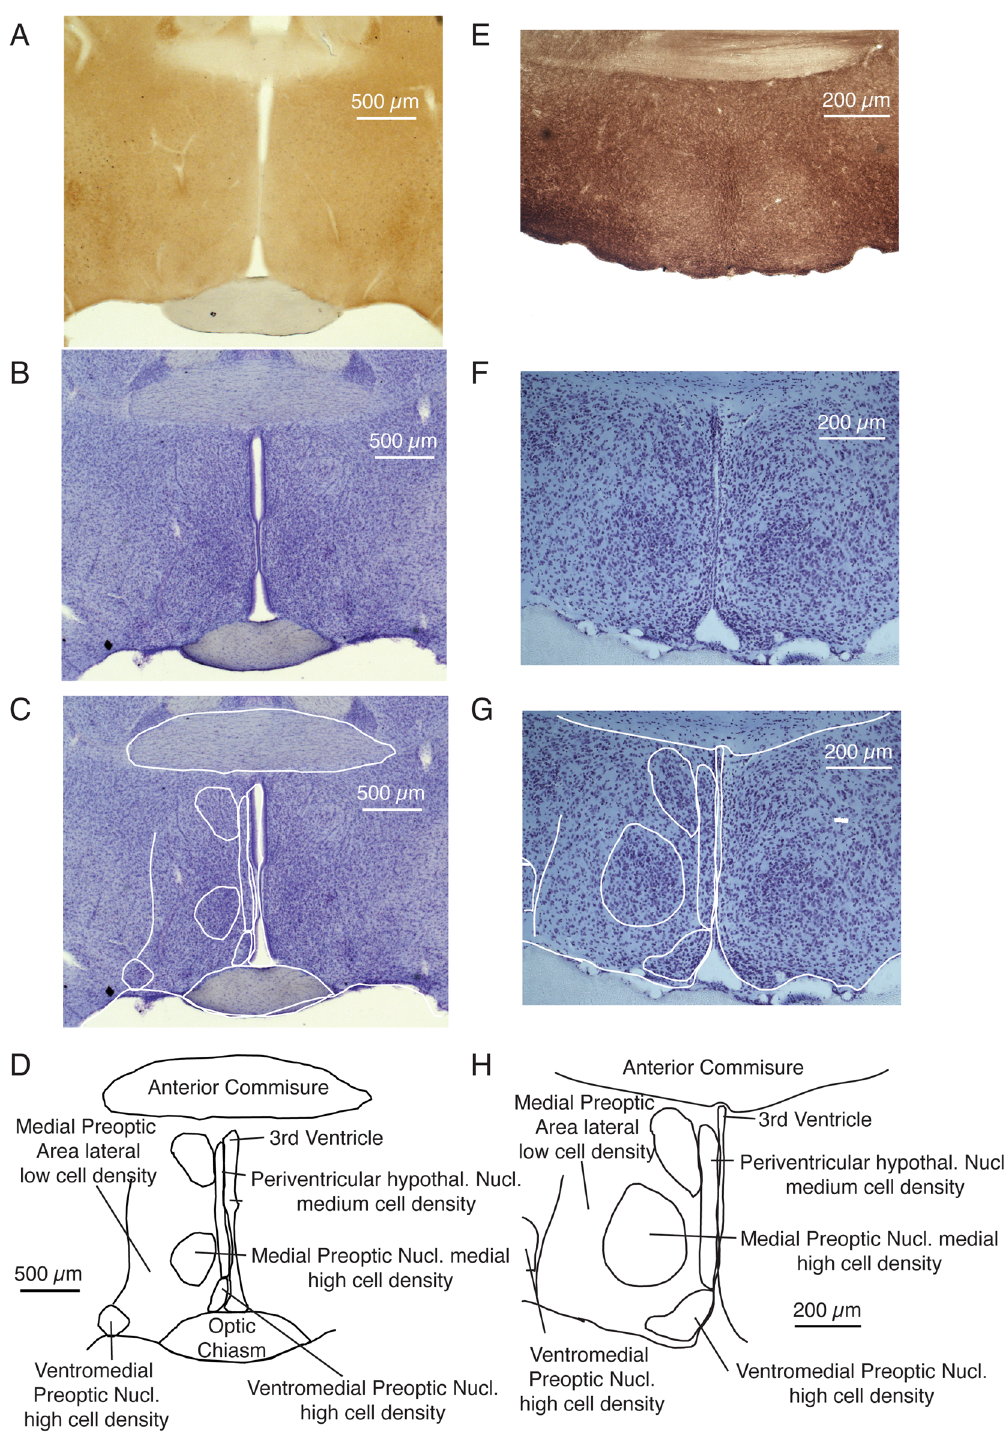
Figure 2. Identification of medial preoptic nuclei in rats and Etruscan shrews. ( A ) Rat coronal brain section of the medial preoptic area stained for cytochrome oxidase activity. The staining pattern is relatively indistinct. ( B ) Rat coronal brain section containing the MPA of rat stained for Nissl substance. Variations in cell density indicate different medial preoptic nuclei. ( C ) Same section as above with cytoarchitectonic divisions highlighted by white lines. ( D ) Cytoarchitectonic divisions named according to the Paxinos and Watson nomenclature. Our further analysis focused on the Medial preoptic nucleus (MPN). ( E ) Etruscan shrew coronal brain section of the medial preoptic area stained of cytochrome oxidase reactivity. The medial part of Medial preoptic nucleus stands out by a lower cytochrome oxidase reactivity (whitish). ( F ) Etruscan shrew coronal brain section containing the MPA of rat stained for Nissl substance. Variations in cell density indicate different medial preoptic nuclei. ( G ) Same section as above with cytoarchitectonic divisions highlighted by white lines. ( H ) Cytoarchitectonic divisions named according to the Paxinos and Watson nomenclature. Note the distinct medial preoptic